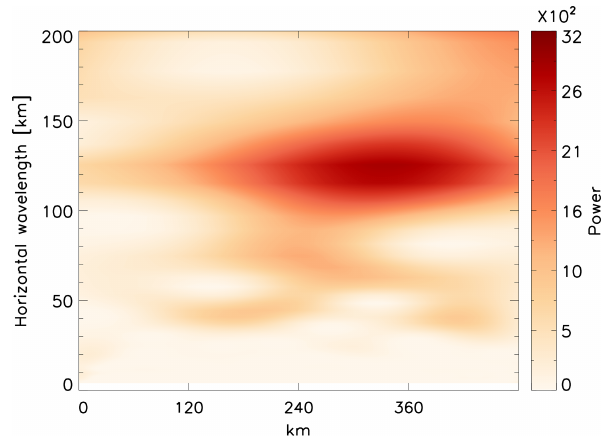
Figure 7. Wavelet power spectrum along the red line at 01:00:18LT in Fig.